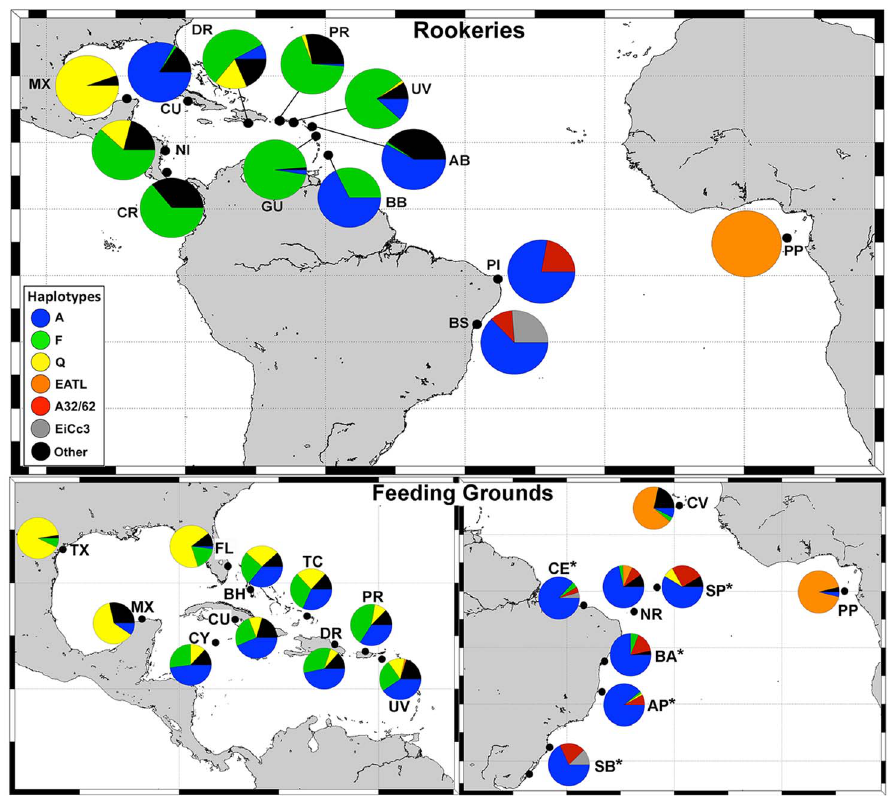
Figure 2. Main haplotype frequencies of genetically described populations in the Atlantic. *study areas described in this work. Rookeries: BS= Bahia/Sergipe, PI= Pipa, PP= Principe, BB= Barbados, GU= Guadeloupe, AB= Antigua & Barbuda, UV= U.S. Virgin Islands, PR= Puerto Rico, DR= Dominican Republic, CR= Costa Rica, NI= Nicaragua, CU= Cuba, MX= Mexico. Feeding grounds: SP= Sa˜o Pedro and Sa˜o Paulo, NR= Noronha/Rocas, CE= Ceara´ coast, BA= Bahia coast, AP= Abrolhos Park, SB= South Brazil, PP= Principe, CV= Cape Verde, UV= U.S. Virgin Islands, PR= Puerto Rico, DR= Dominican Republic, TC= Turks & Caicos, BH= Bahamas, FL= Florida, CY= Cayman Islands, MX= Mexico, TX= Texas.